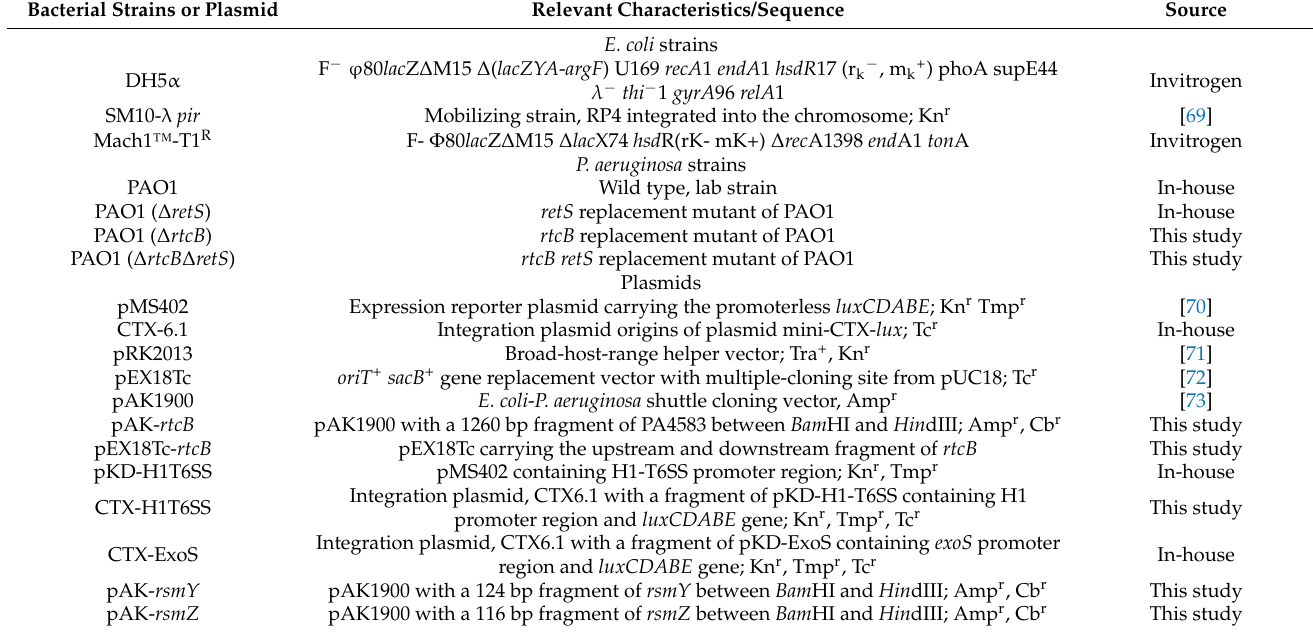
Table 2. Bacterial strains and plasmids used in this